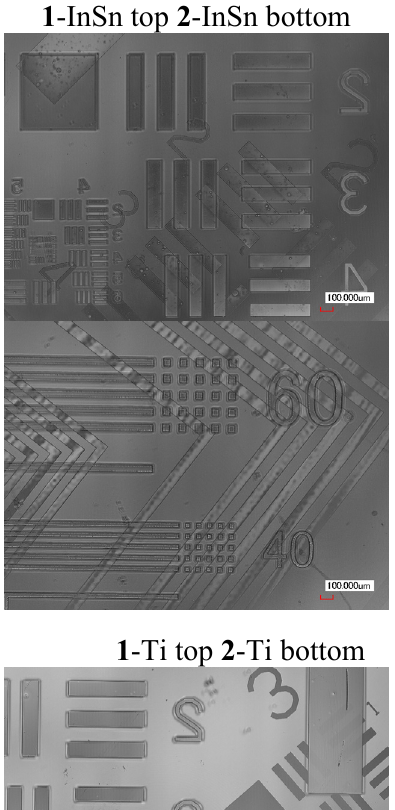
Figure 9. Laser microscope images of quartz substrates with patterned metal oxide films on both sides deposited by two-tone patterning Method